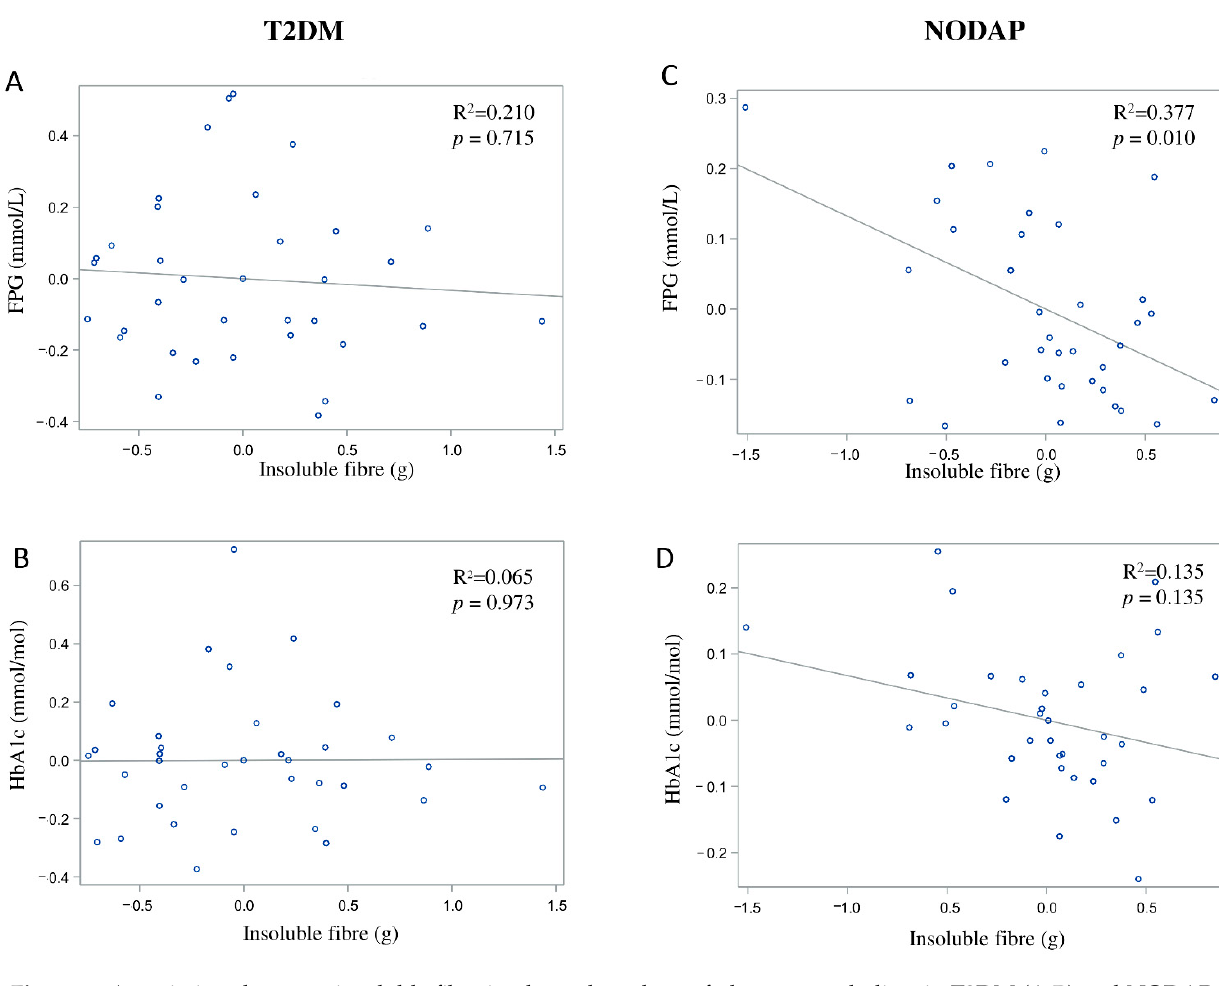
Figure 2. Associations between insoluble fibre intake and markers of glucose metabolism in T2DM ( A , B ) and NODAP ( C , D ). Abbreviations: T2DM = Type 2 diabetes or prediabetes prior to acute pancreatitis. NODAP = New-onset diabetes or prediabetes after acute pancreatitis. HbA1c = glycated haemoglobin. FPG = fasting plasma glucose. R 2 = adjusted R 2 value (coefficient determinations). Footnotes: FPG, HbA1c, and insoluble fibre were log-transformed. R 2 values were adjusted for age, sex, BMI, energy intake (log-transformed), use of anti-diabetic medications, aetiology of pancreatitis, recurrence of pancreatitis, and presence of pancreatic necrosis.